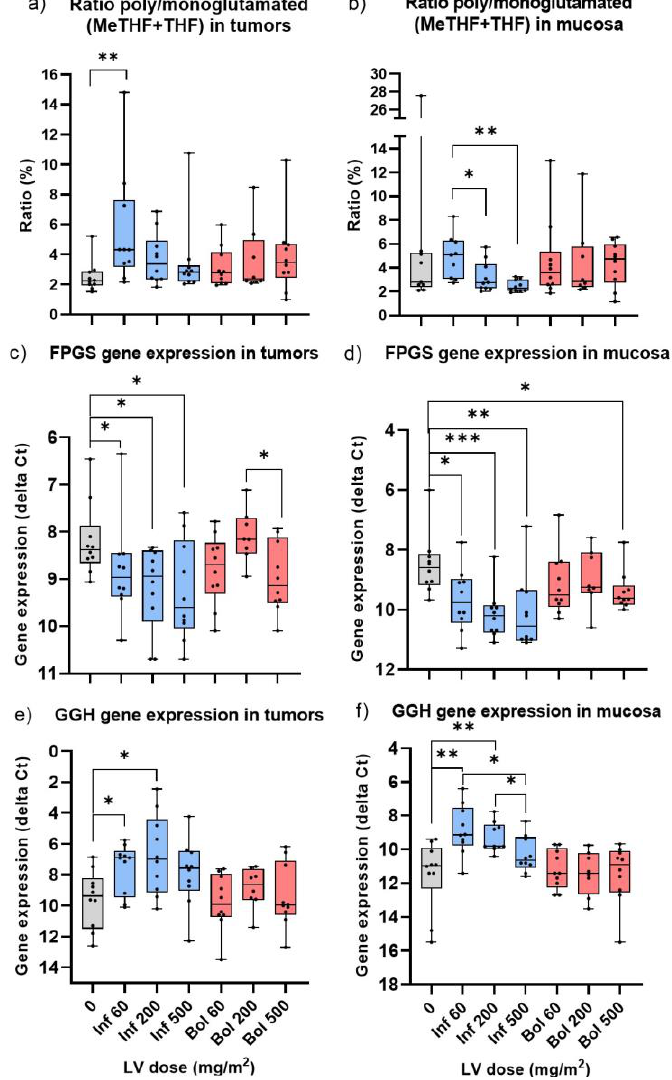
Figure 7. Ratio of polyglutamated/monoglutamated folates, FPGS gene expression, and GGH gene expression in tumors ( a , c , e ) and mucosa ( b , d , f ) of patients receiving no LV, as well as different doses of LV given as two-hour infusion (blue boxes) or bolus injection (red boxes). * p ≤ 0.05; ** p ≤ 0.01, *** p ≤ 0.001.